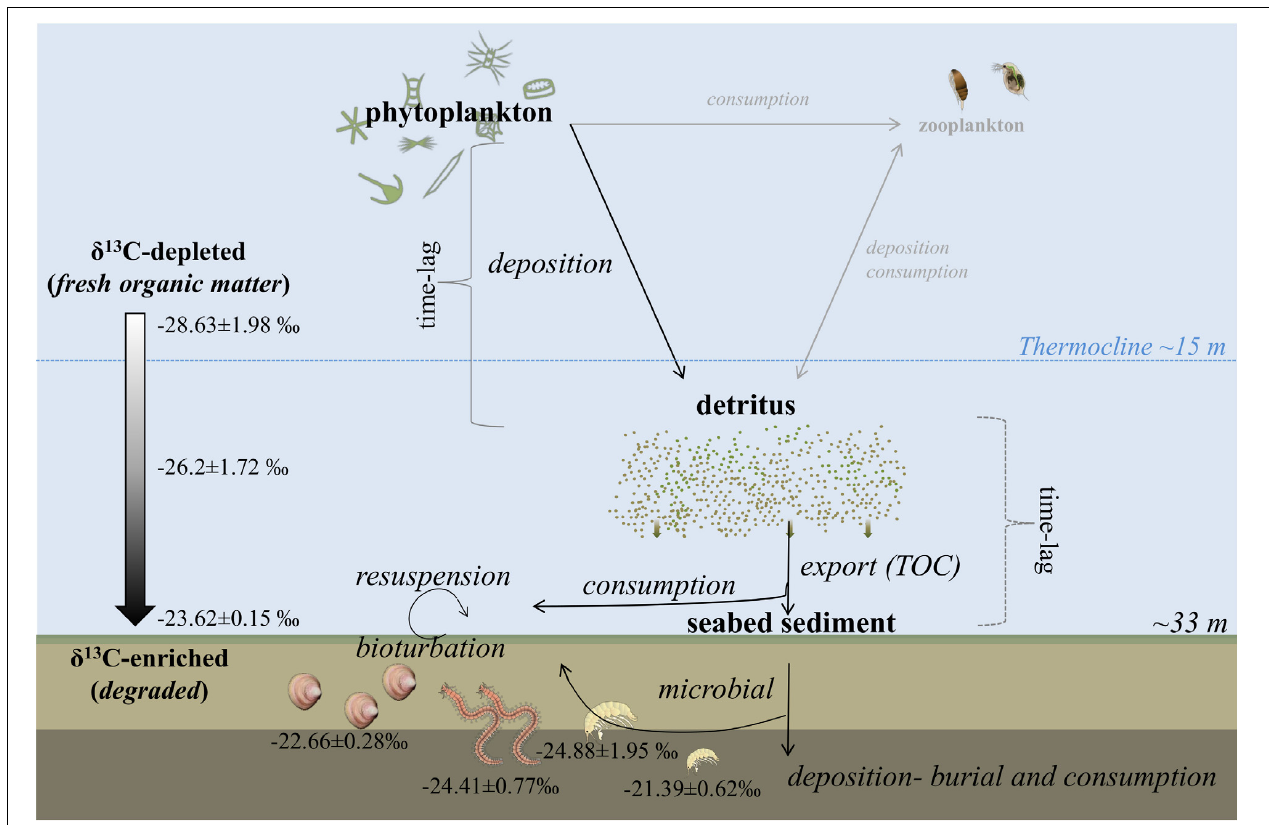
FIGURE 8 | Conceptual diagram depicting the major pathways of organic matter assimilation from primary producers (i.e., phytoplankton) in the water column to higher trophic levels (i.e., deposit feeders) proposed for Storfjärden bay (Finland). The δ 13 C values are given as the temporal average obtained in this study ( Supplementary Tables S7–S9 ). In light gray, we show those compartments not measured in this study (e.g., zooplankton). Images are courtesy of the Integration and Application Network, University of Maryland Center for Environmental Science